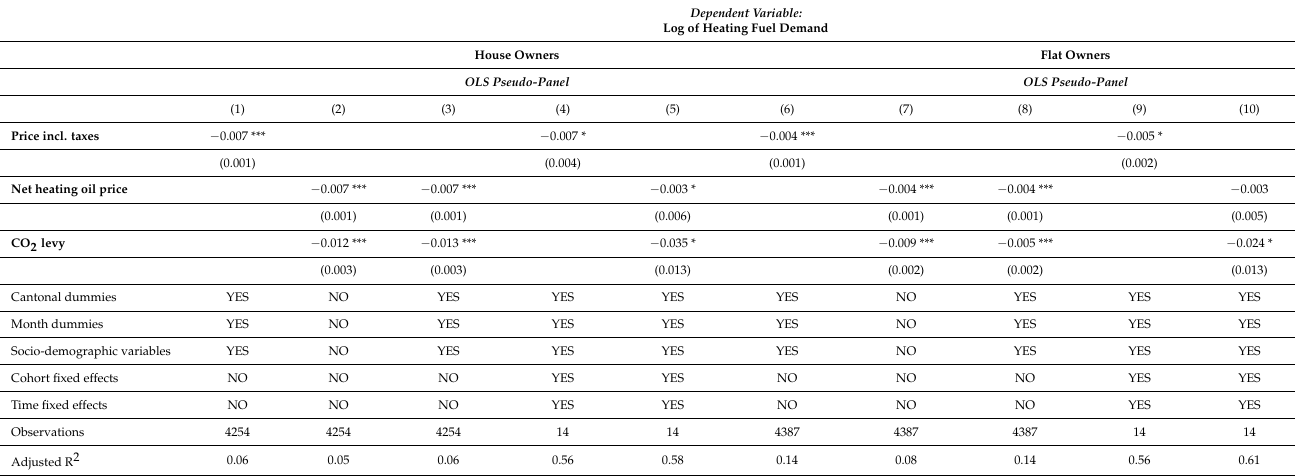
Table 4. Semielasticity